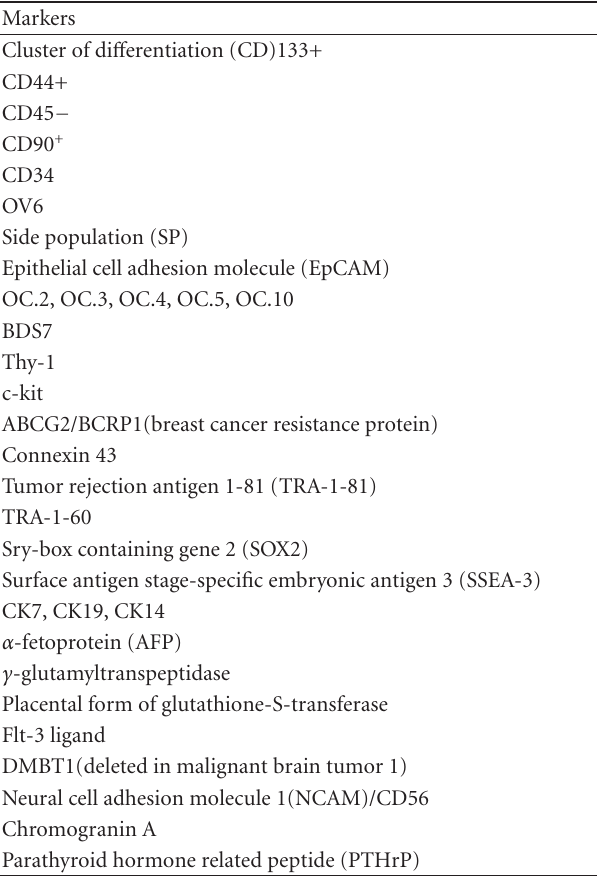
Table 1: Markers that have aided in the identification of stem cells.